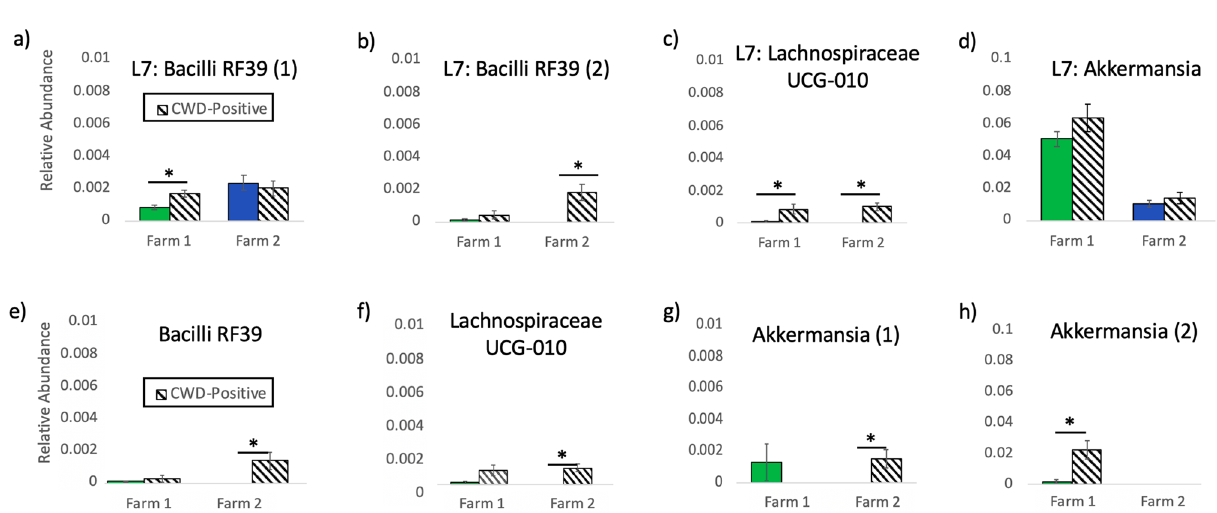
Figure 4. Differentially abundant microbial taxa by CWD status. Differentially abundant taxa by CWD Status, including ( a ) an L7 (roughly species) level taxa in the Bacilli class, order RF39, ( b ) a second L7 level taxa in the Bacilli class, order RF39, ( c ) an L7 level taxa in the Lachnospiraceae UCG-10 family, ( d ) an L7 level taxa in the Akkermansia genera, ( e ) an ASV (roughly strain level) in the Bacilli class, order RF39 (formerly Mollicutes RF39), ( f ) an ASV in the Lachnospiraceae UCG-10 family, ( g ) an ASV in the Akkermansia genera, ( h ) a second ASV also in the Akkermansia